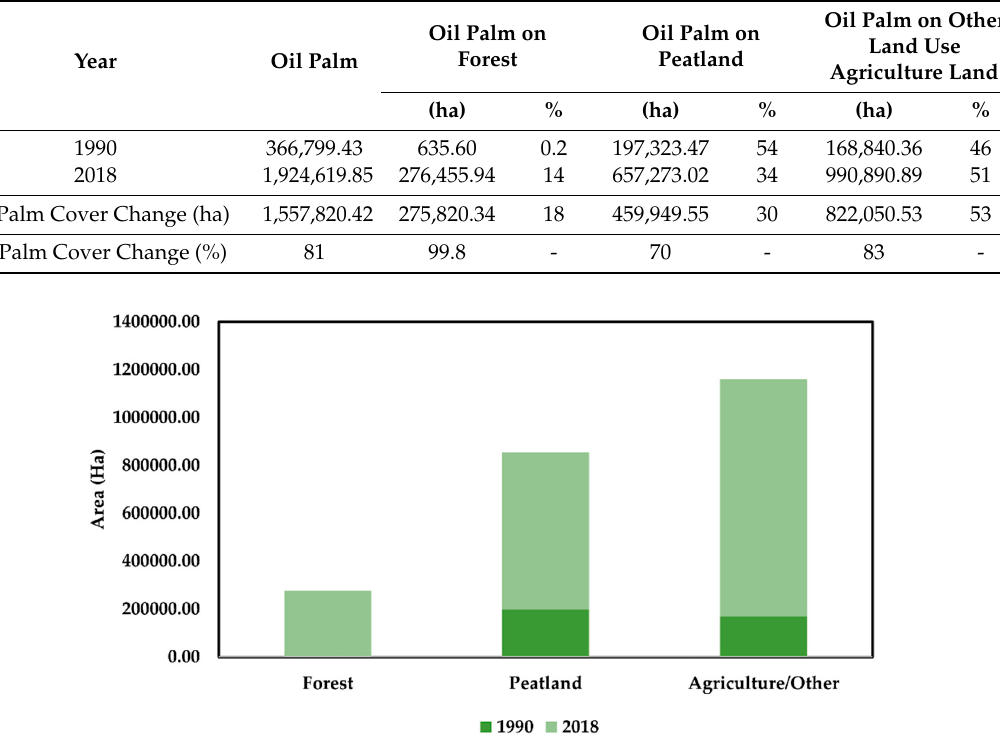
Figure 5. Oil palm expansion on forest, peatland, and agricultural land in Sarawak in 1990 and 2018 (note: oil palm area on forest 1990 = 636 ha and oil palm area on forest 2018 = 276,820 ha).